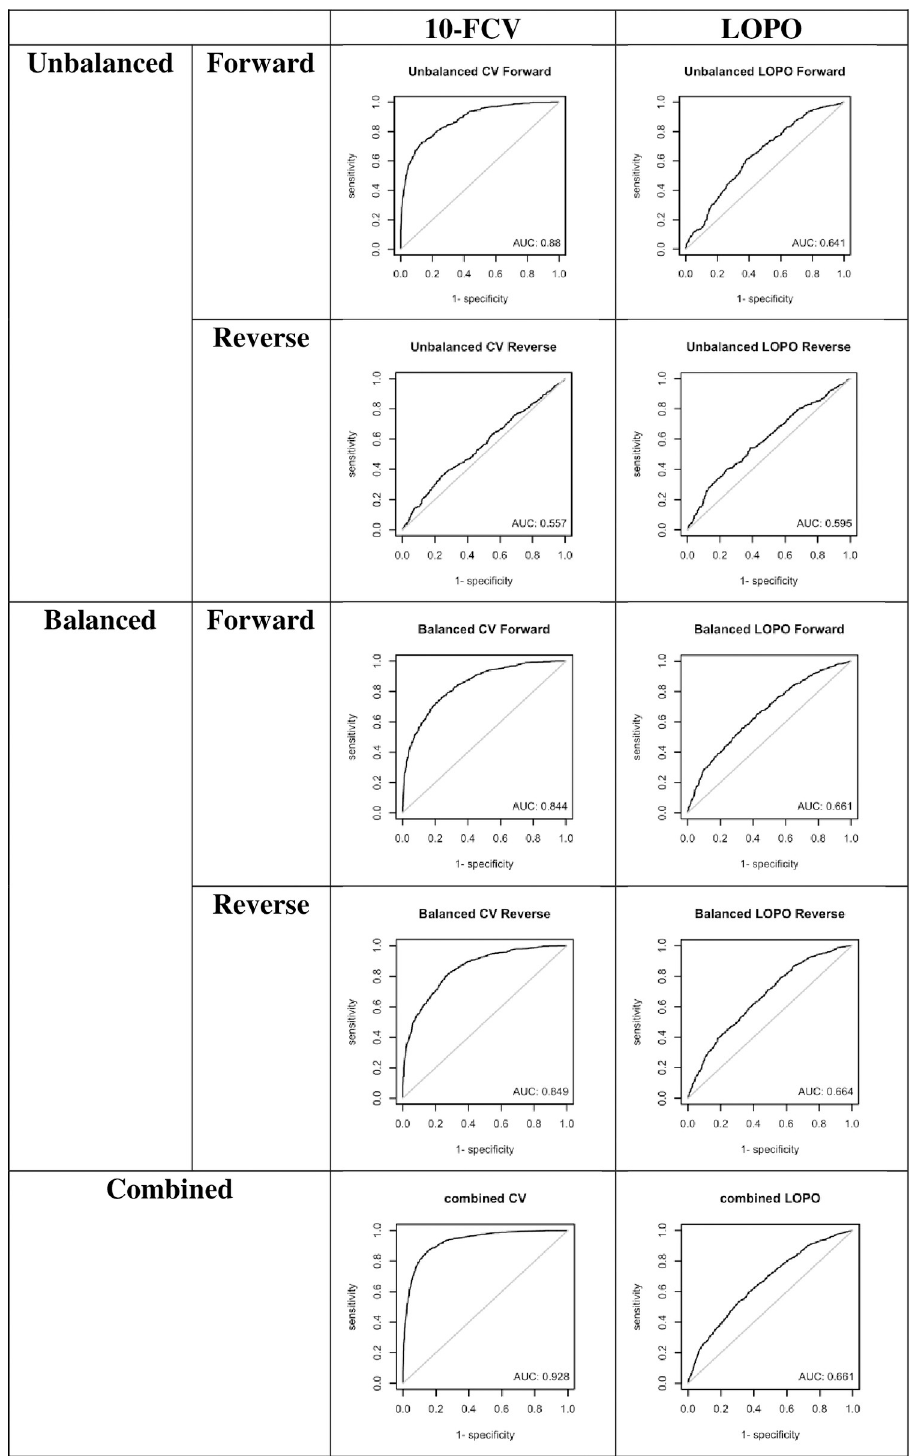
Fig 2. ROC curves and their AUCs of ΔΔ G prediction of the unbalanced, balanced and combined approaches. Different ΔΔ G values were used as thresholds to convert the prediction into binary stabilizing and destabilizing classes.